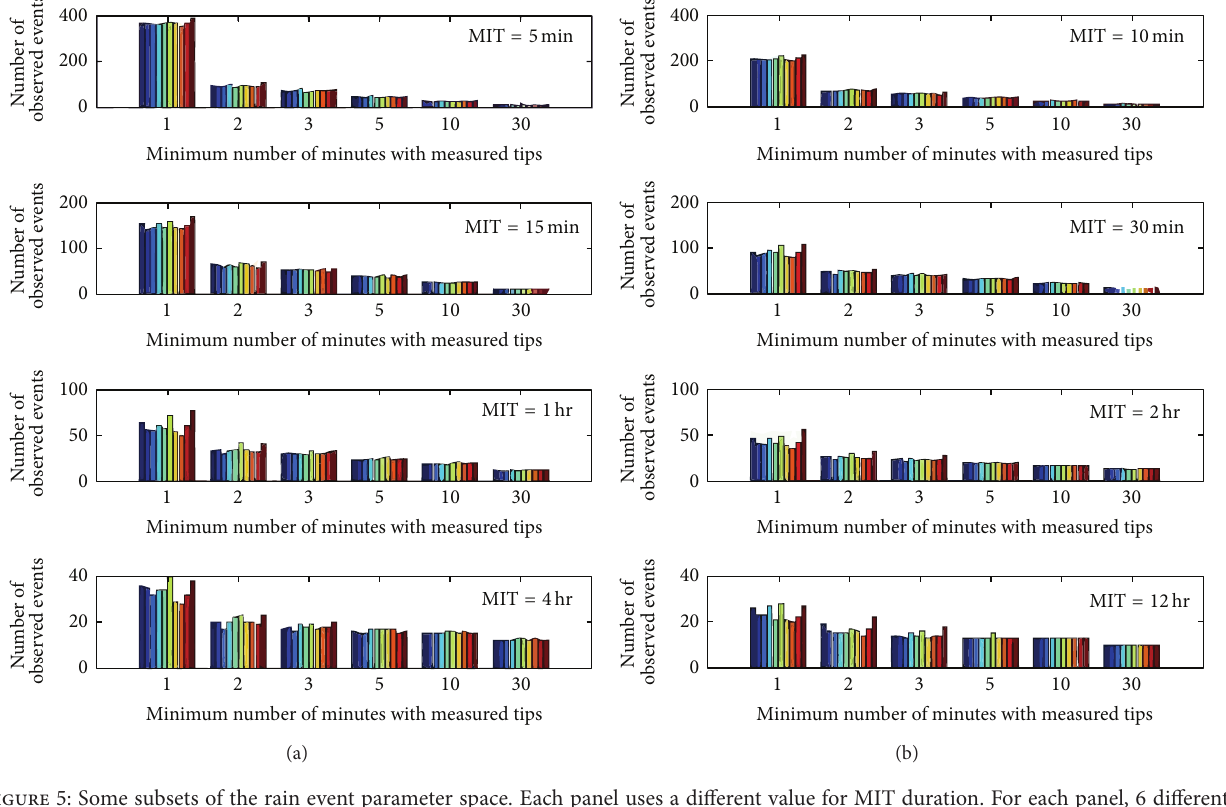
Figure 5: Some subsets of the rain event parameter space. Each panel uses a different value for MIT duration. For each panel, 6 different values are displayed for L . Each of the ten detectors is displayed in a different color. The reader should take care to note the different scales on the 𝑦 -axes from panel to panel. Although there is approximate agreement between the detectors, there is nonnegligible variability in the total number of events detected for most combinations of MIT and L . Note also the very large number of L = 1 events that do not qualify as events once L = 2+ ; these brief events are particularly numerous for brief